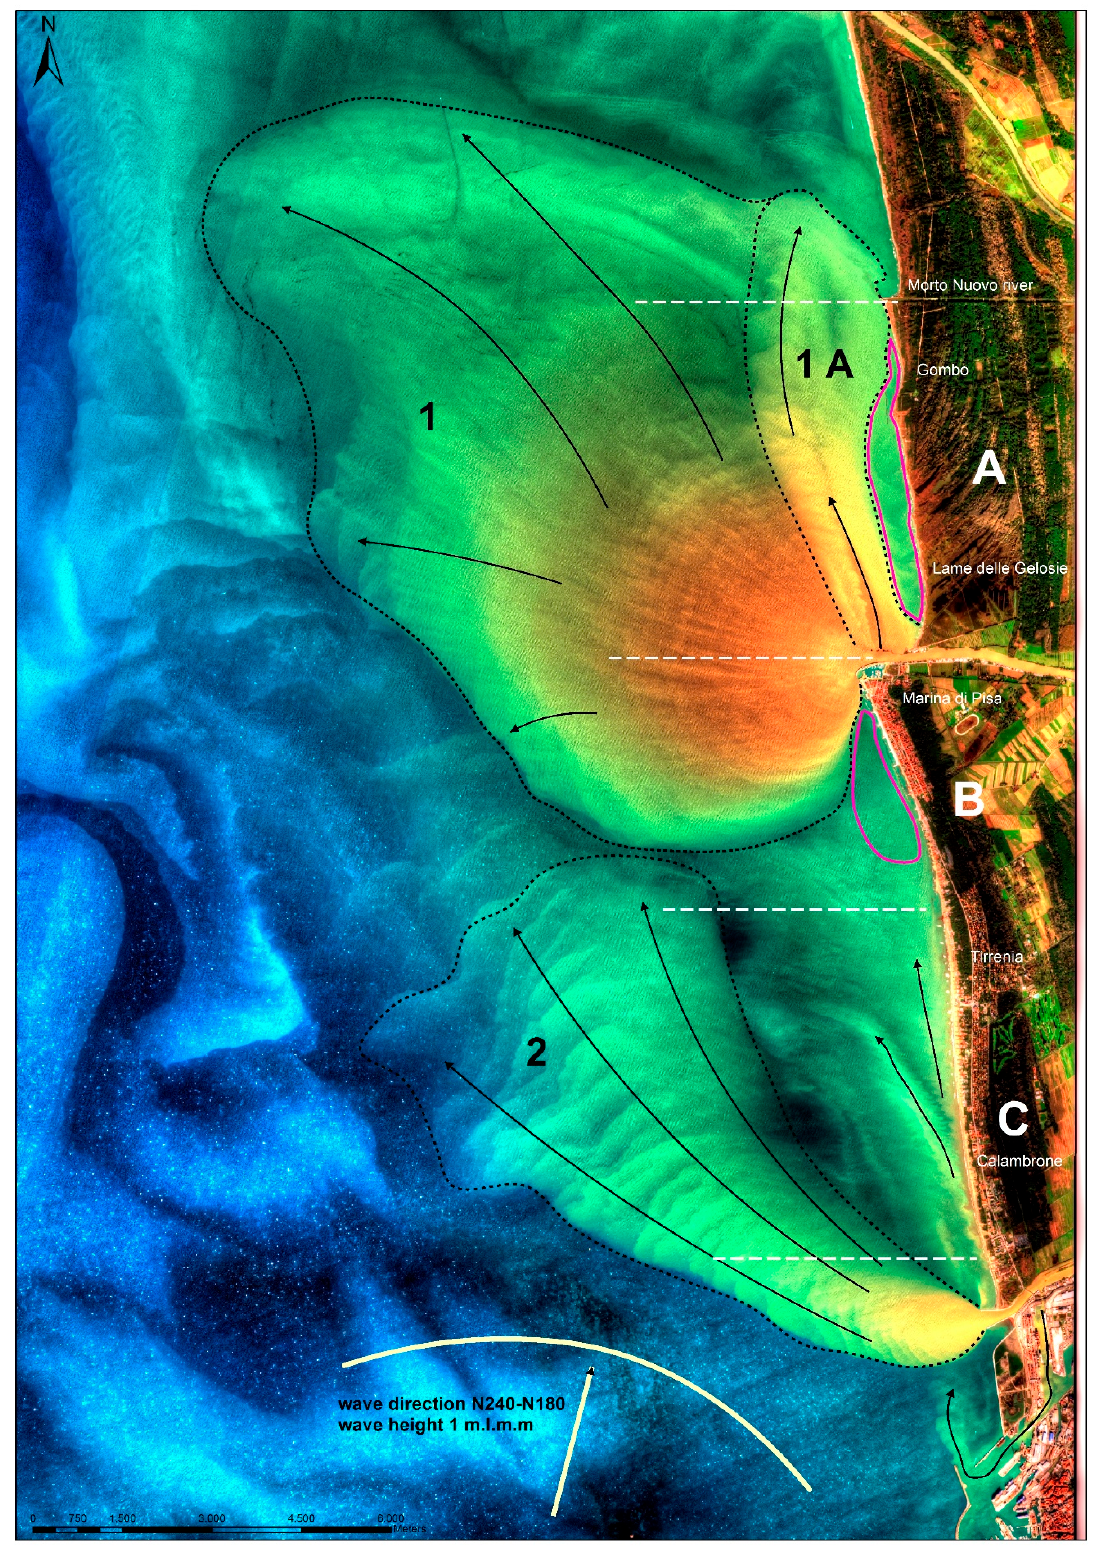
Figure 6. Sentinel-2 image showing the Arno flood event of 3 December 2019 characterized by a fluvial discharge of 902 m 3 /s at the S. Giovanni alla Vena gauge and wave direction N 240–180. A, B and C indicate specific coastal stretches to which reference has been made in the text. Black arrows show the sediment flow directions derived from a qualitative analysis of the image using the tone mapping method to emphasize the contrast. Dashed lines highlight the main plumes at the different river mouths. Purple lines enclose the shadow areas.